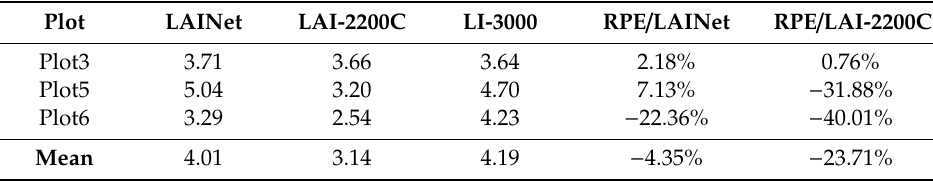
Table 4. Statistics of three kinds of field LAI measurements in